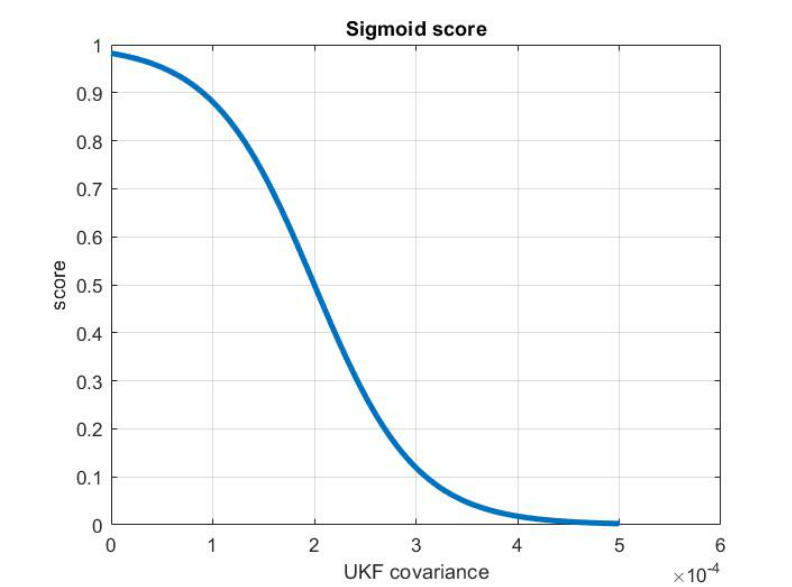
Figure 5. Inverse sigmoid